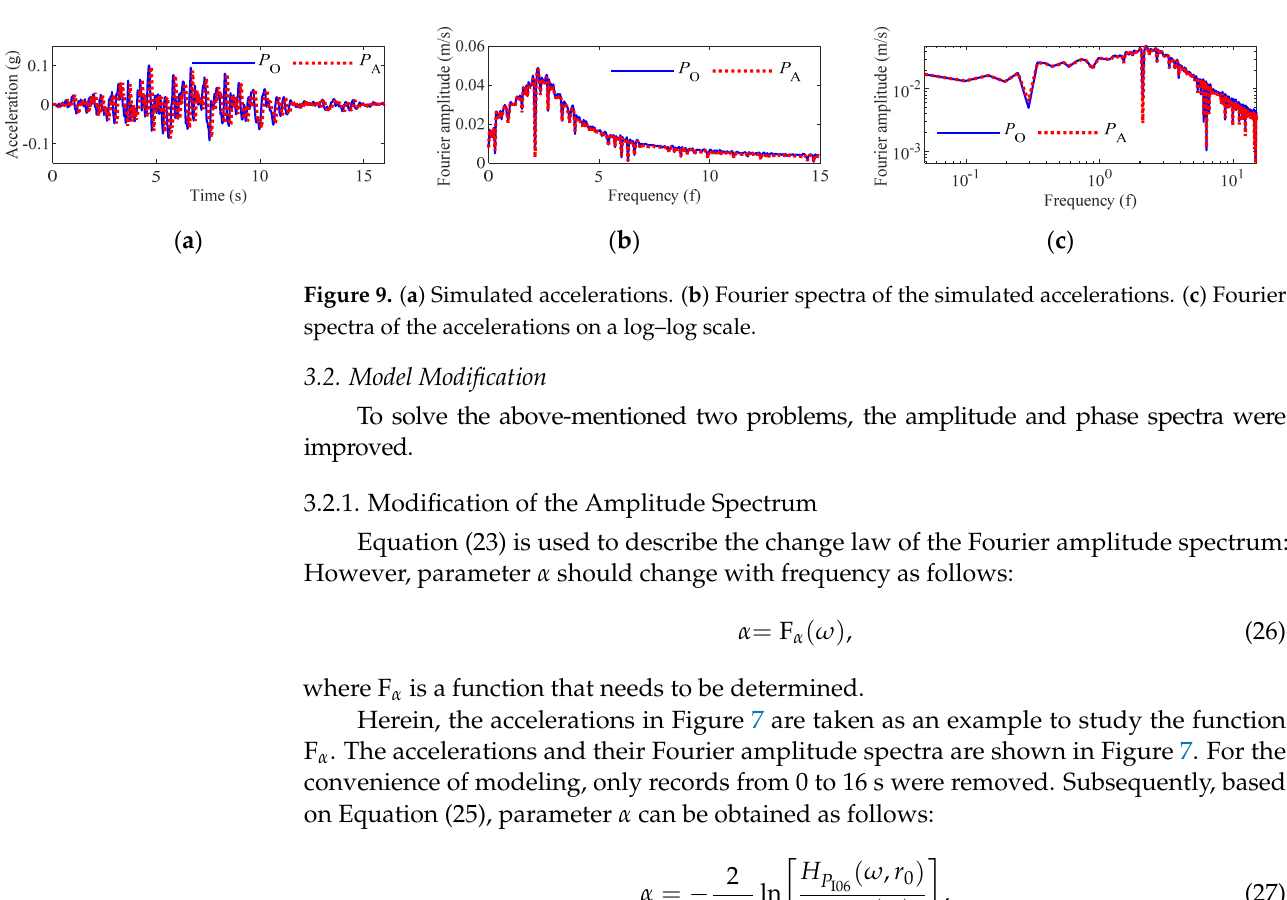
Figure 8. A simple seismic field.